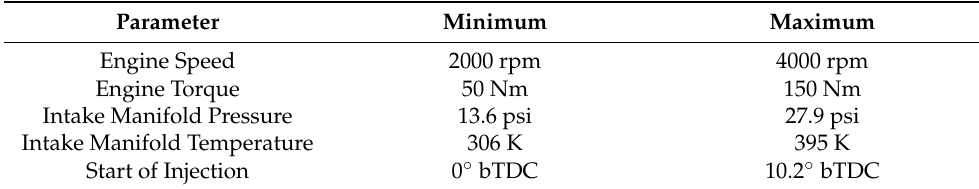
Table 1. Range of engine testing